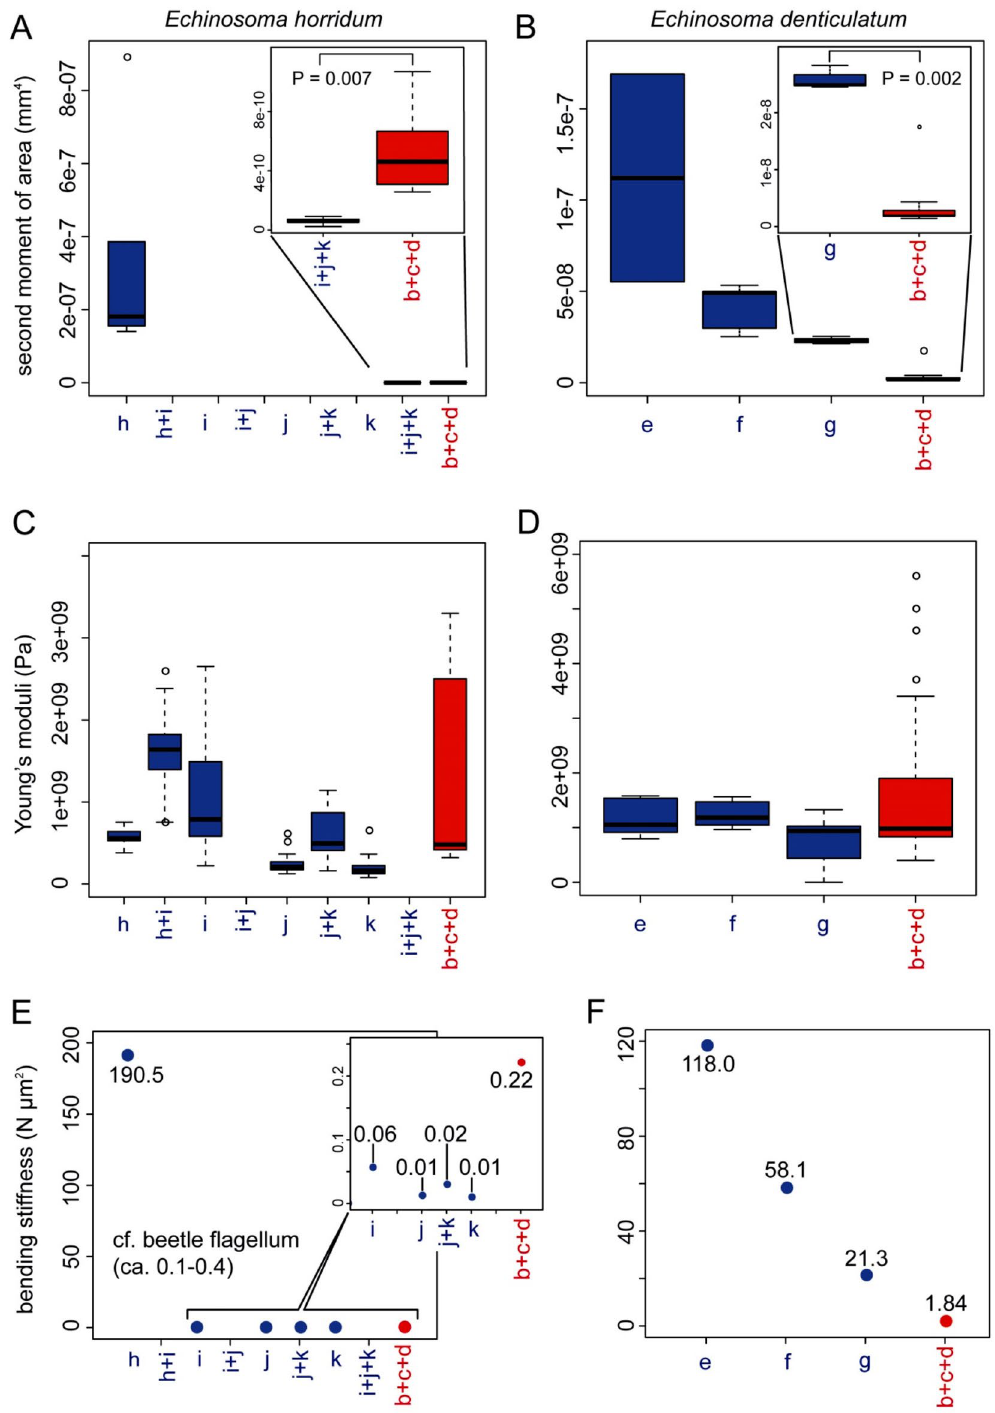
Figure 8. The second moment of area, Young’s moduli and bending stiffnesses along the virga and spermatheca of Echinosoma horridum ( A , C , E ) and E. denticulatum . ( B , D , F ). ( A , B ) The calculated second moment of area using Fiji equipped with the plugin BoneJ. ( C , D ) Estimated Young’s moduli. ( E , F ) Resulting bending stiffnesses. The alphabets correspond to locations whose second moment of area and Young’s modulus were measured and shown in schemes of the virga and spermatheca ( E ) and ( F ) in Fig.